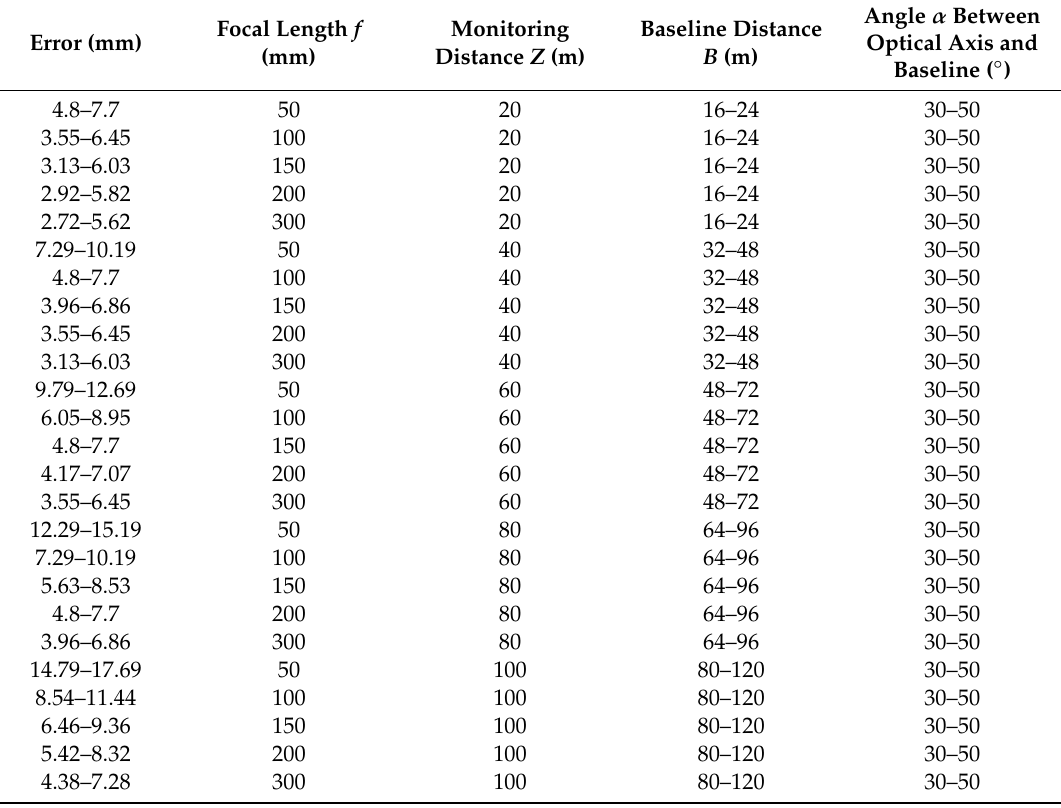
Table 2. Recommendation of structure parameters combination using the binocular vision measurement system.